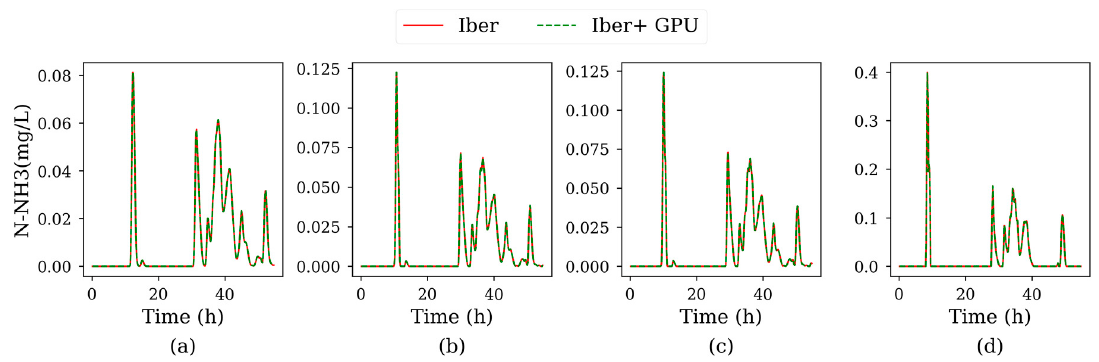
Figure A4. Time series of ammoniacal nitrogen for Test 3, sampled at control points P1 ( a ), P2 ( b ), P3 ( c ) and P4 ( d ).